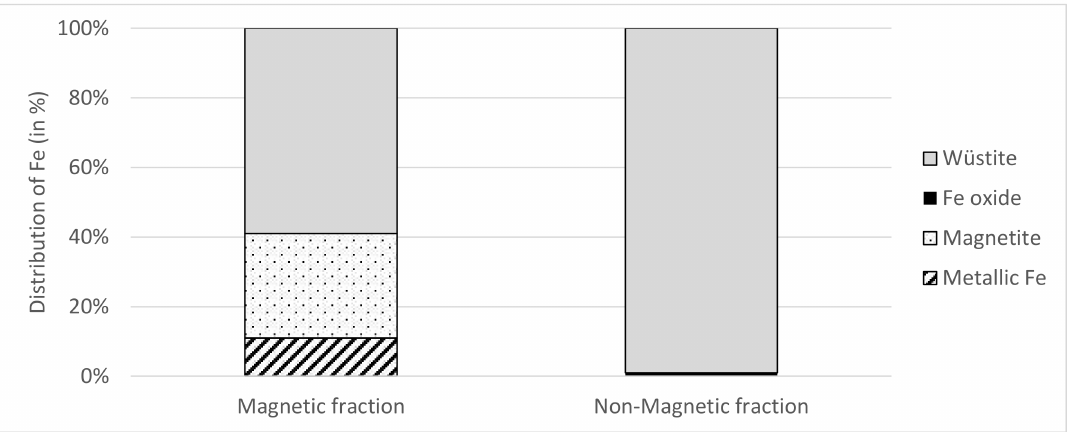
Figure 2. Mössbauer results on iron phases distribution in the samples obtained after dry low intensity magnetic separation of the size fraction +0.25–1